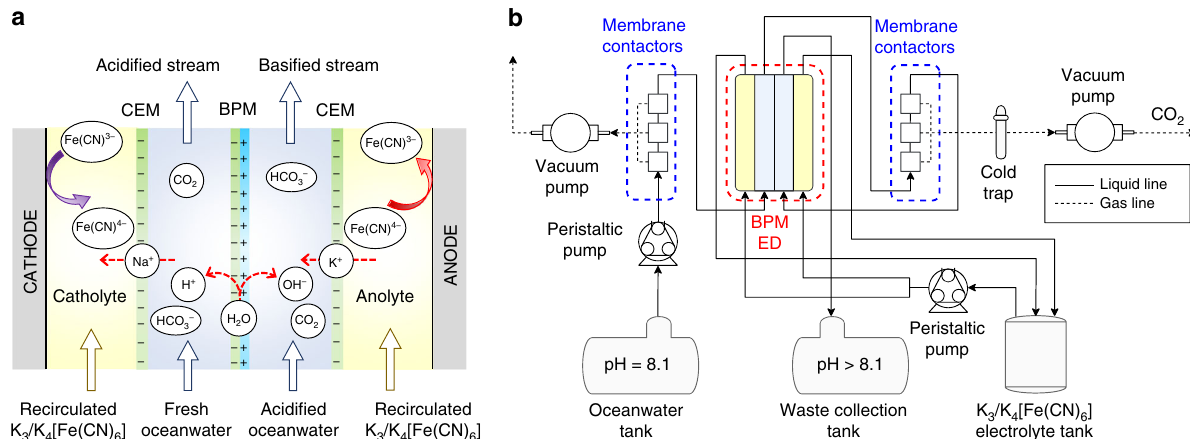
Fig. 1 BPM electrodialysis and CO 2 capture system. a Schematic illustration of the BPM electrodialysis cell. b Process fl ow diagram of the experimental setup for CO 2 capture from